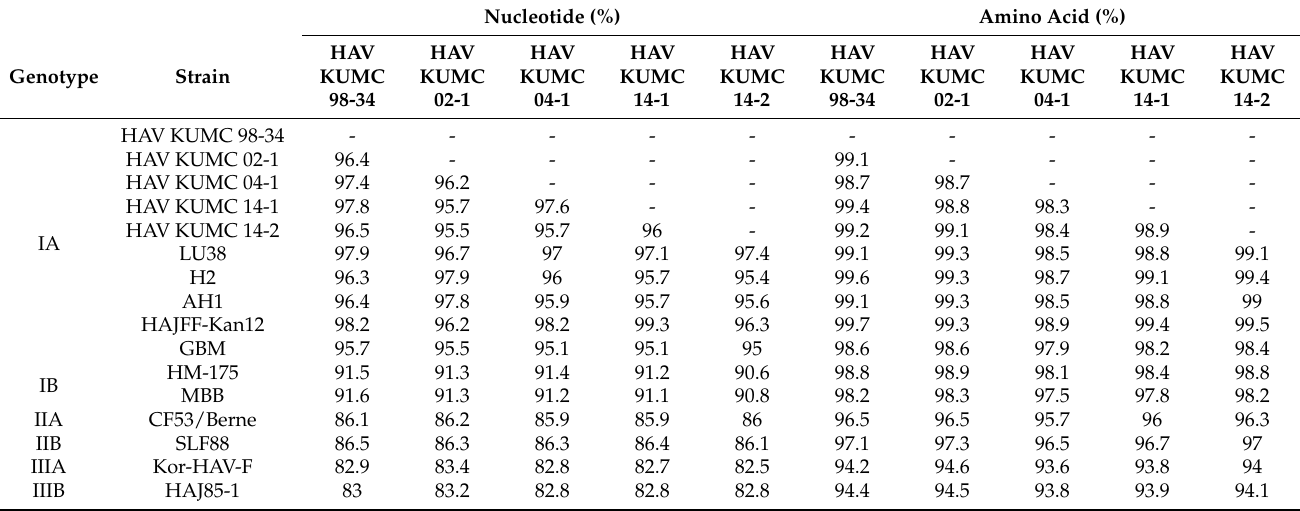
Table 3. Genetic relationship between hepatitis A virus (HAV) from the Republic of Korea and representative